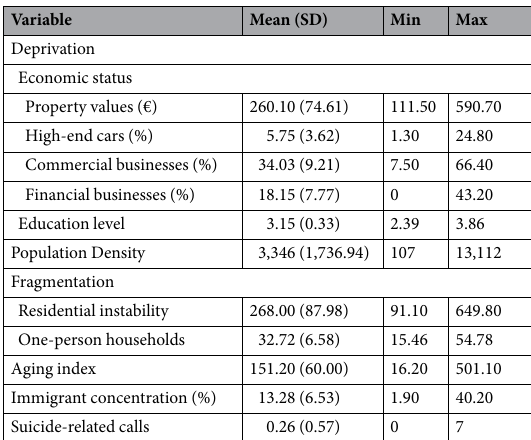
Table 1. Variables (Mean, Standard Deviation, Minimum and Maximum Values) at the Census Block Group and Year Level (2013 data). Abbreviations: SD, standard deviation; Min, minimum; Max,